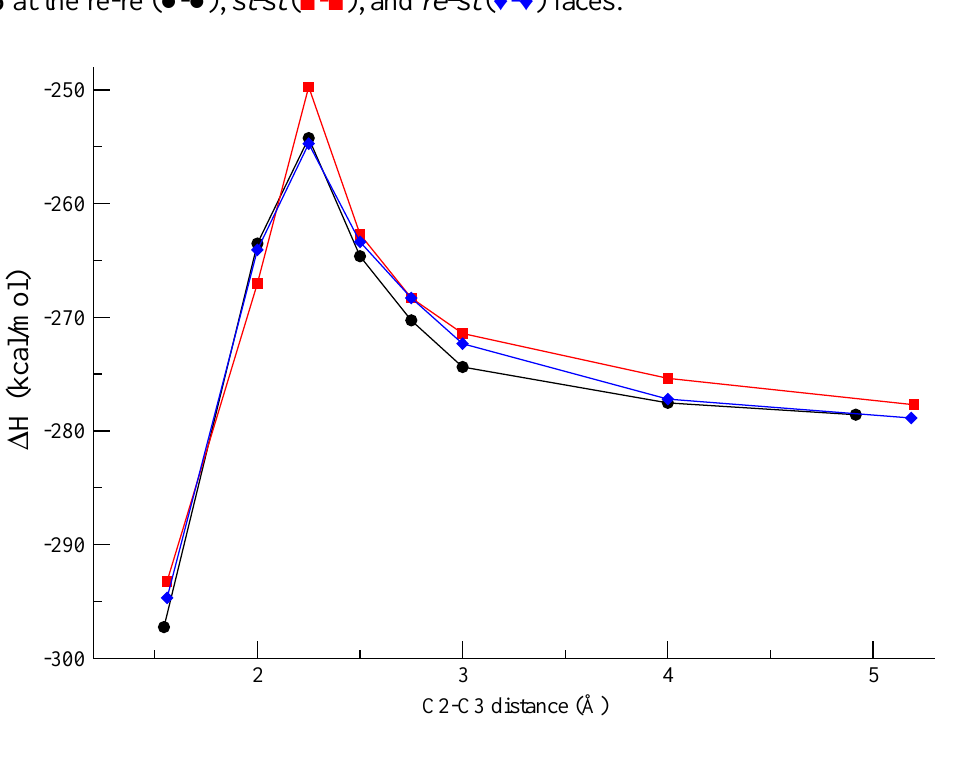
Figure 4a. Molecular geometry of the van der Waals pre-reactive complex with the monomers at the re-re face ( a ), and the corresponding bisquinomethide product ( b ).